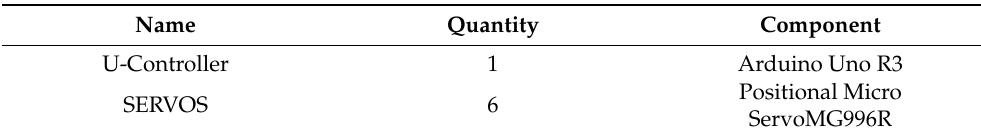
Figure 3. Circuit diagram of the microcontroller and servos interfacing for assembly of the robotic arm. Table 4. Components for the robotic